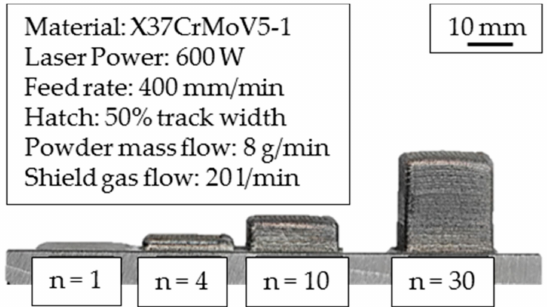
Figure 2. Evolution of three-dimensional cuboids using Laser Metal Deposition (LMD) according to [14]. To receive high geometrical accuracy, the z -shift must be adjusted every few